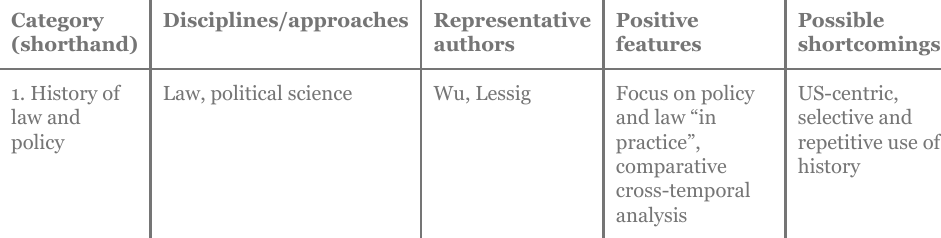
Table 1. Streams of literature relevant to the history of digital rights contention Category Disciplines/approaches Representative (shorthand)